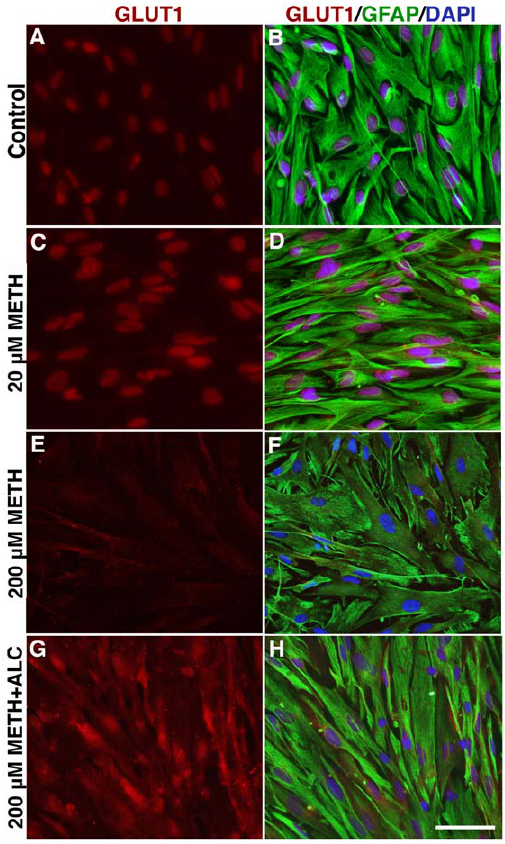
Figure 7. Expression of GLUT1 in METH treated human astrocytes: A-H: Immunocytochemistry of GLUT1 (red) merged with GFAP (green) and DAPI (blue) in human astrocytes. The expression of GLUT1 is shown in control ( A–B ), 20 m M METH ( C–D ), 200 m M METH ( E–F ) and 200 m M METH + 100 m M ALC ( G–H ). Mouse anti-GLUT1 and rabbit anti-GFAP were used as primary antibodies for overnight at 4 u C. Anti-mouse-IgG Alexa Fluor 594 for GLUT1 and anti-rabbit-IgG Alexa Fluor 488 for GFAP were used as the secondary antibodies. Scale bar indicates 10 m m in all panels.